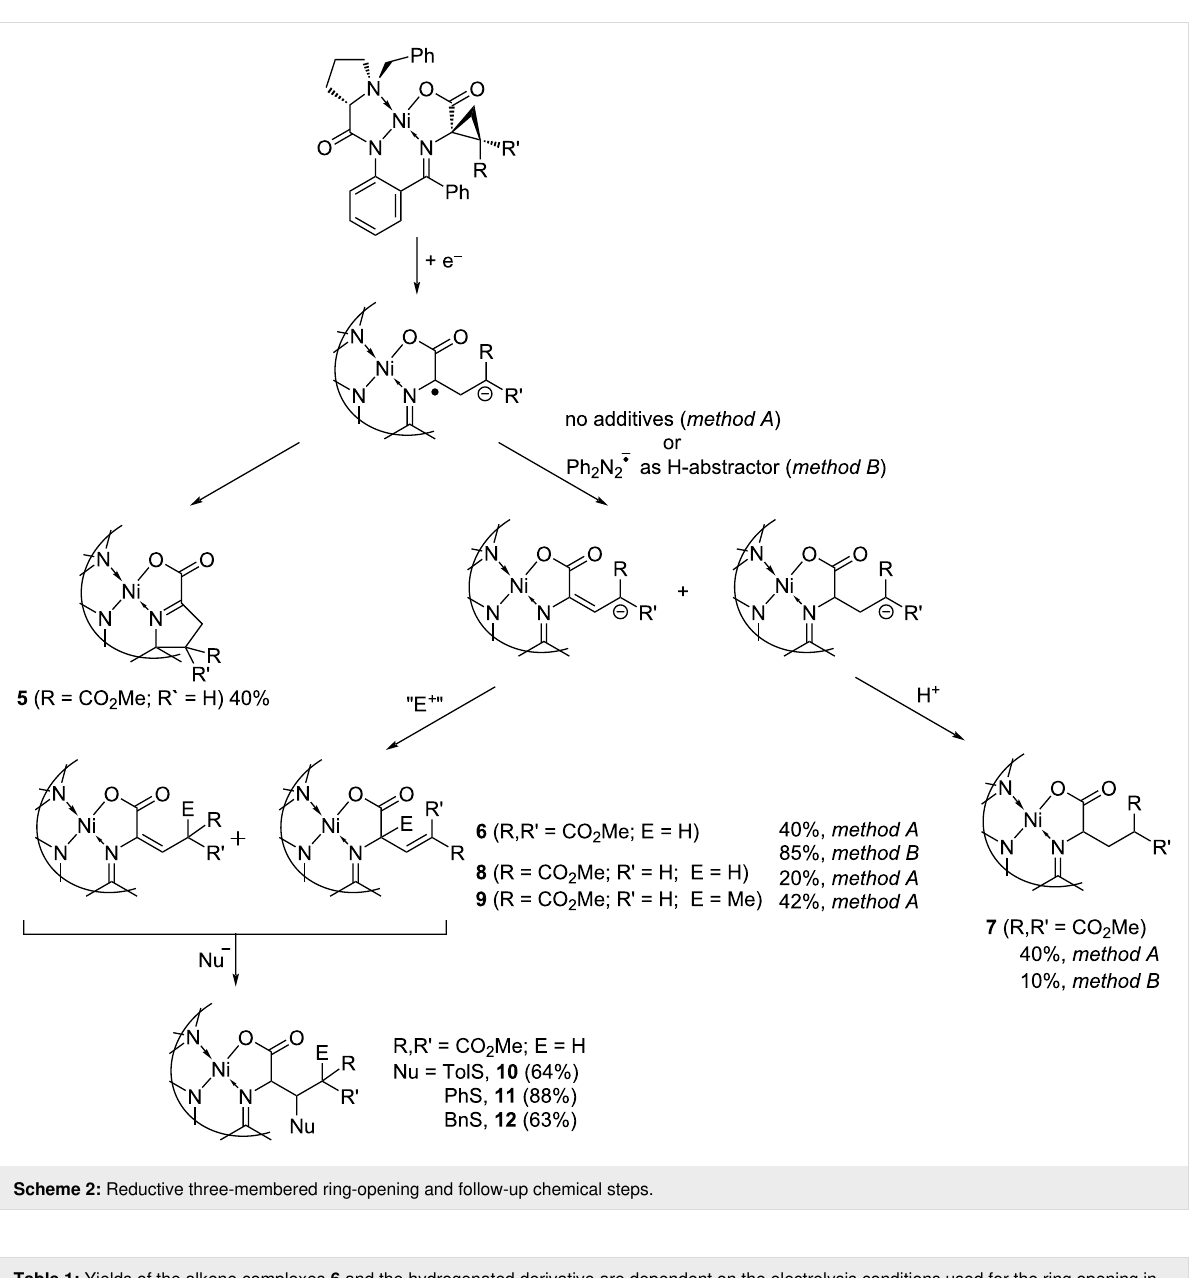
Table 1: Yields of the alkene complexes 6 and the hydrogenated derivative are dependent on the electrolysis conditions used for the ring opening in complex 4 (8 mM) (GC, DMF, 0.09 M Bu 4 NBF 4 or 0.8 M LiCl). conditions alkene complexes 6 hydrogenated supporting electrolyte, additives WE